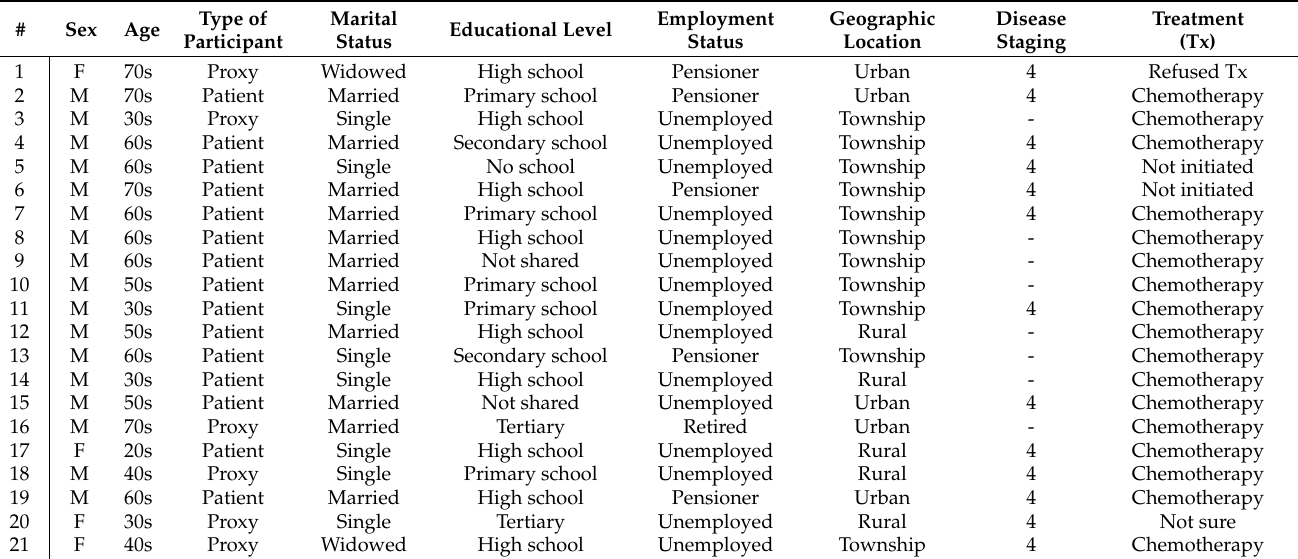
Table 1. Characteristics of respondents (N =